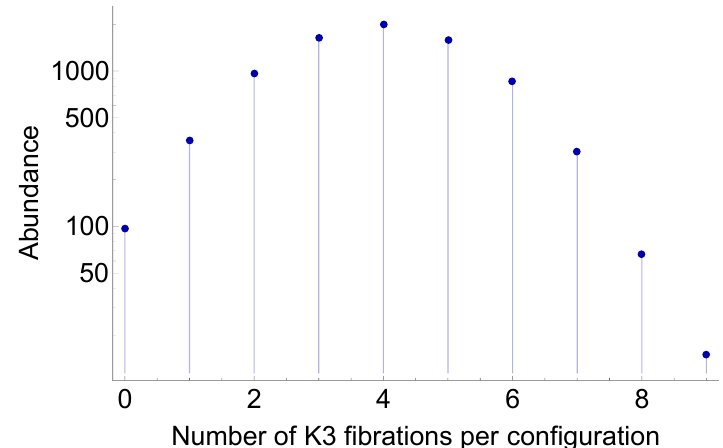
Figure 2 . Distribution of obvious K3 (cid:12)bration abundance in the CICY threefold list (excluding product manifolds). The values lie in the range 0 - 9. We (cid:12)nd 30 ; 974 (cid:12)brations in total and on average each CICY threefold con(cid:12)guration is obviously K3 (cid:12)bered in 3 : 9 di(cid:11)erent ways.